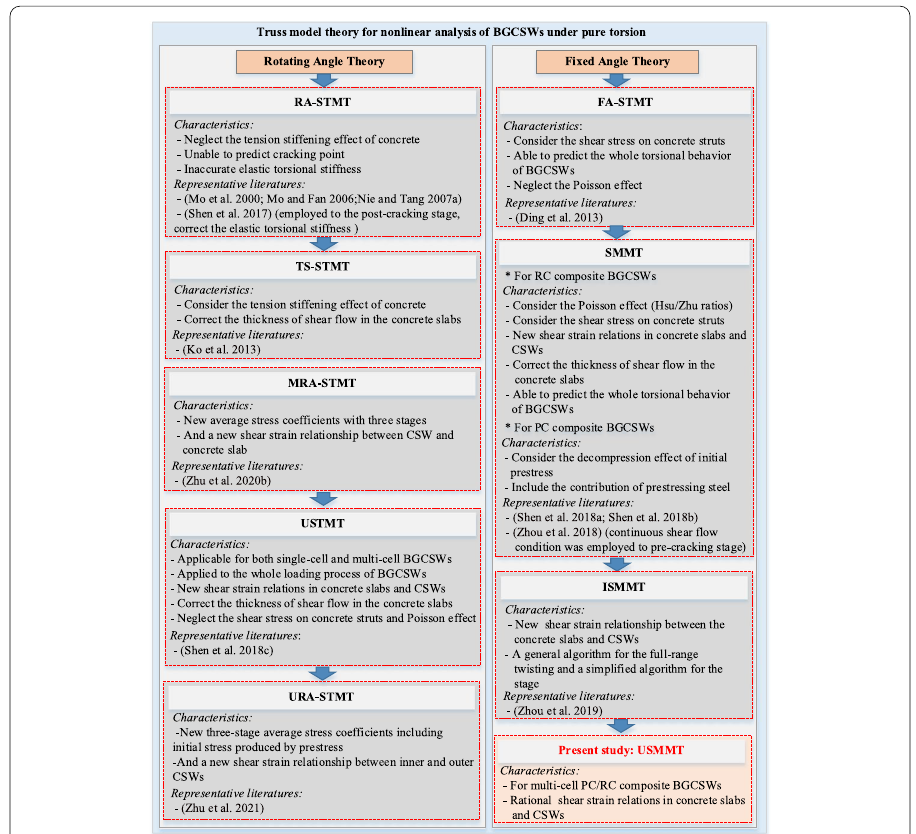
Fig. 1 Progress of the theoretical models for nonlinear torsional analysis of